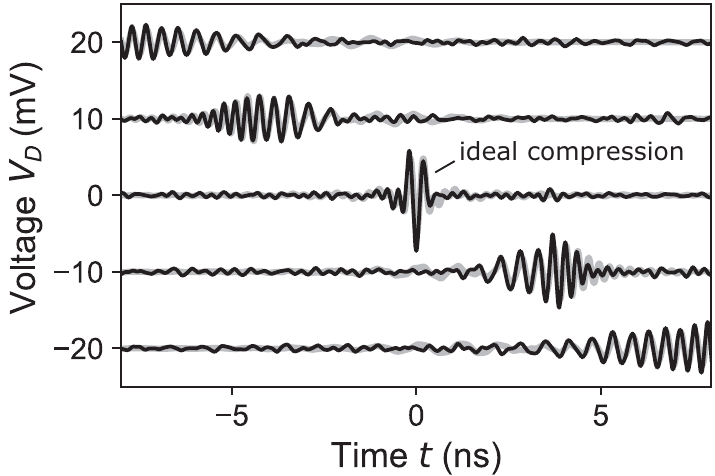
FIG. 9. Nonideal input signals. Time-resolved measurements of the SAW response for an input signal with duration deviation of t − t ∈ ½ − 10 ; − 5 ; 0 ; 5 ; 10 (cid:2) ns. The semitransparent line in the background shows the course expected from an impulse-response S N